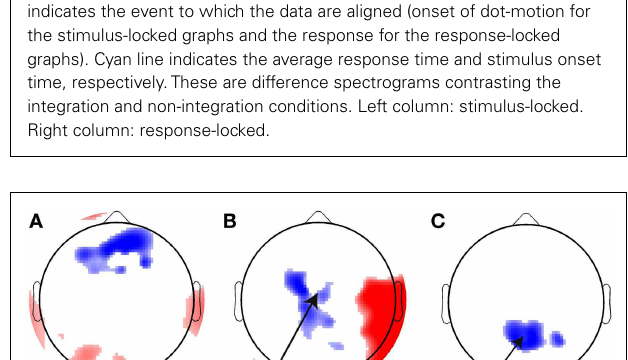
FIGURE 9 | Canonical correlations as a function of frequency, with the DDM-modulated model in blue and additional correlation achieved by the RT-modulated model in red, shown separately for the ramp regressor of (A) dots (integration condition) and (B) arrows (non-integration condition). White dots indicate the 97.5th